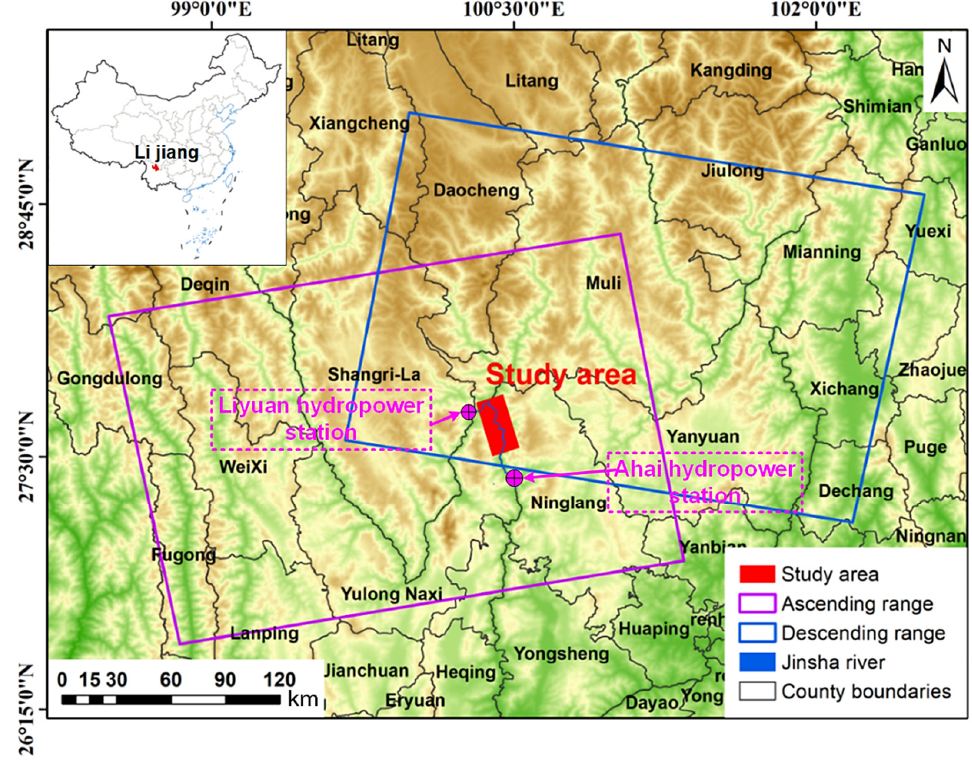
Figure 1. Location of study area and regions of Sentinel-1A data coverage.